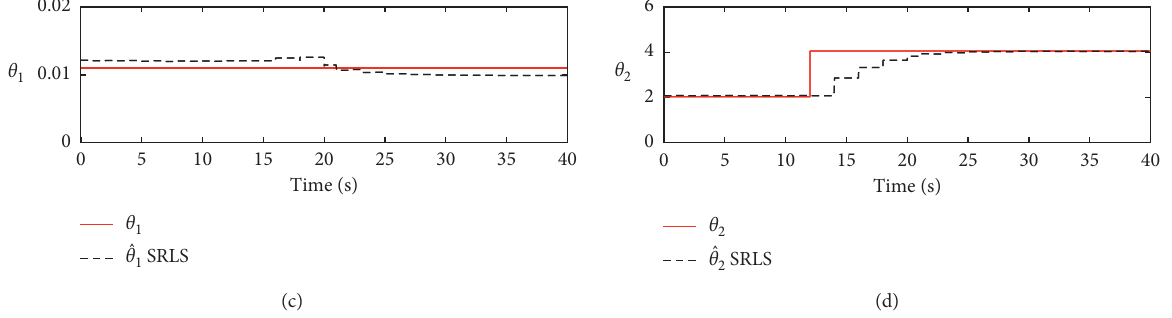
Figure 15: Parameter estimation results with load changing.